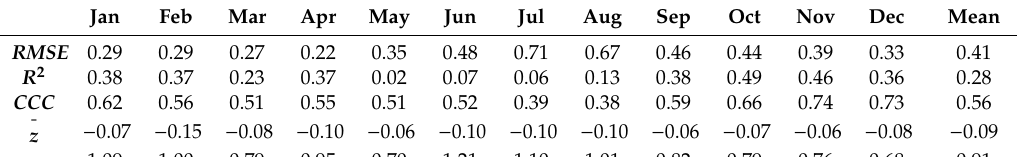
Table 6. Cross validation metrics for monthly ED Spatial Quantile Regression Forests (spQRF) models. RMSE units are in MJ/ha/h, R 2 z-score related values and CCC are unitless.